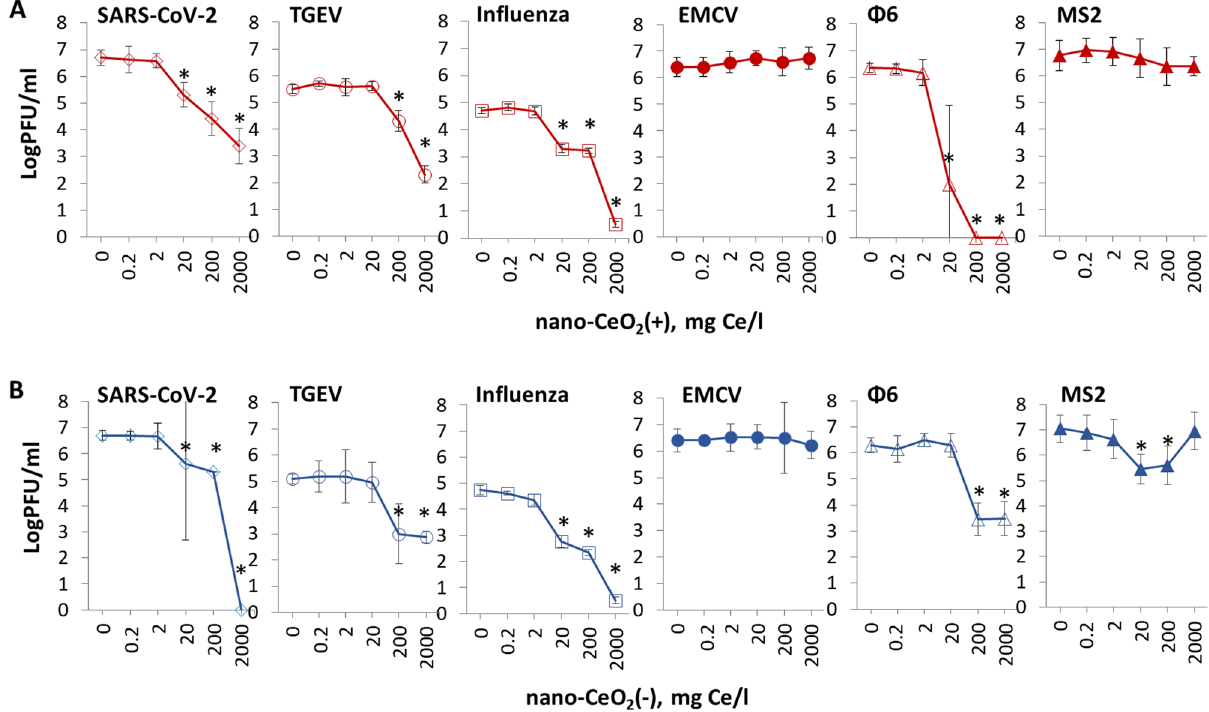
Figure 3. The effect of nano-CeO 2 (+) ( A ) and nano-CeO 2 (−) ( B ) on viral plaque forming activity (log PFU/ ml). Enveloped mammalian viruses and bacteriophages are shown with open symbols; closed symbols represent non-enveloped mammalian viruses and bacteriophages. The differences in initial viral titers are caused by different viral yields in laboratory conditions. *p <